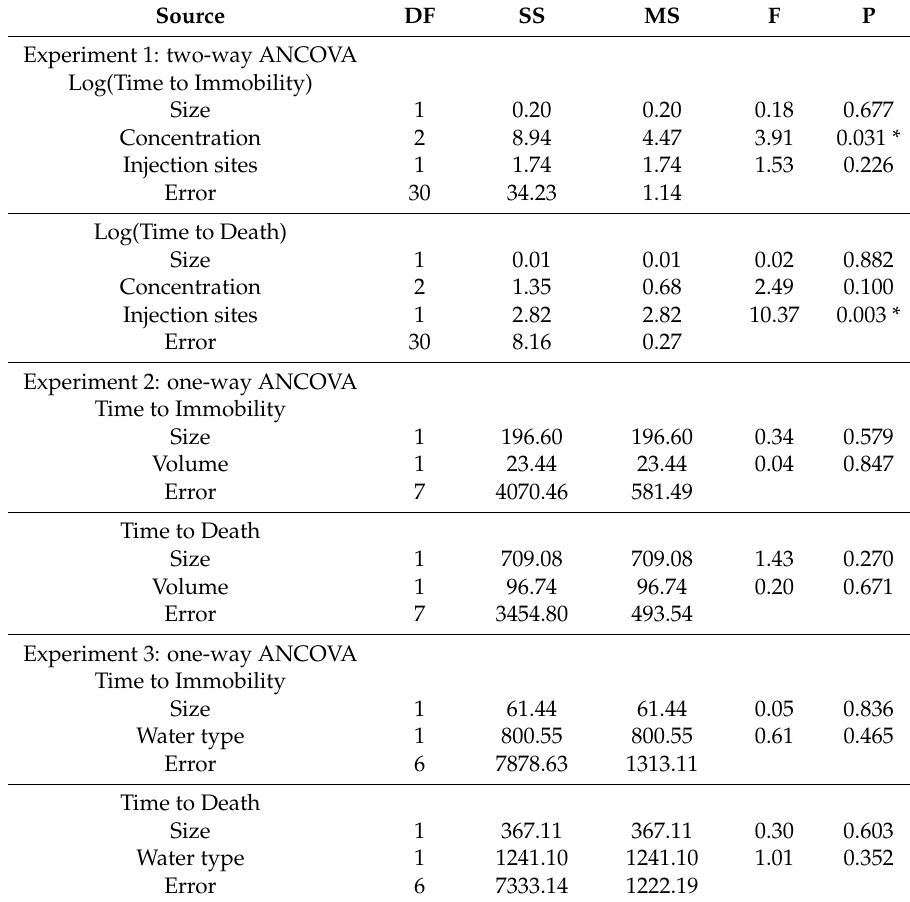
Table 1. Results of the analysis of covariance (ANCOVA) on time to immobility and to death for Acanthaster cf. solaris injected with citric acid. Experiment 1 tests the response to acid concentration (90, 120, or 150 g · L − 1 ) and number of injection sites (two or four). Experiment 2 tests the effect of injection volume (20 mL or 30 mL). Experiment 3 tests the effect of distilled water or seawater as solvent for the citric acid. Body diameter was used as covariate in all models. Data for Experiment 1 were log transformed. * indicates significance at P <